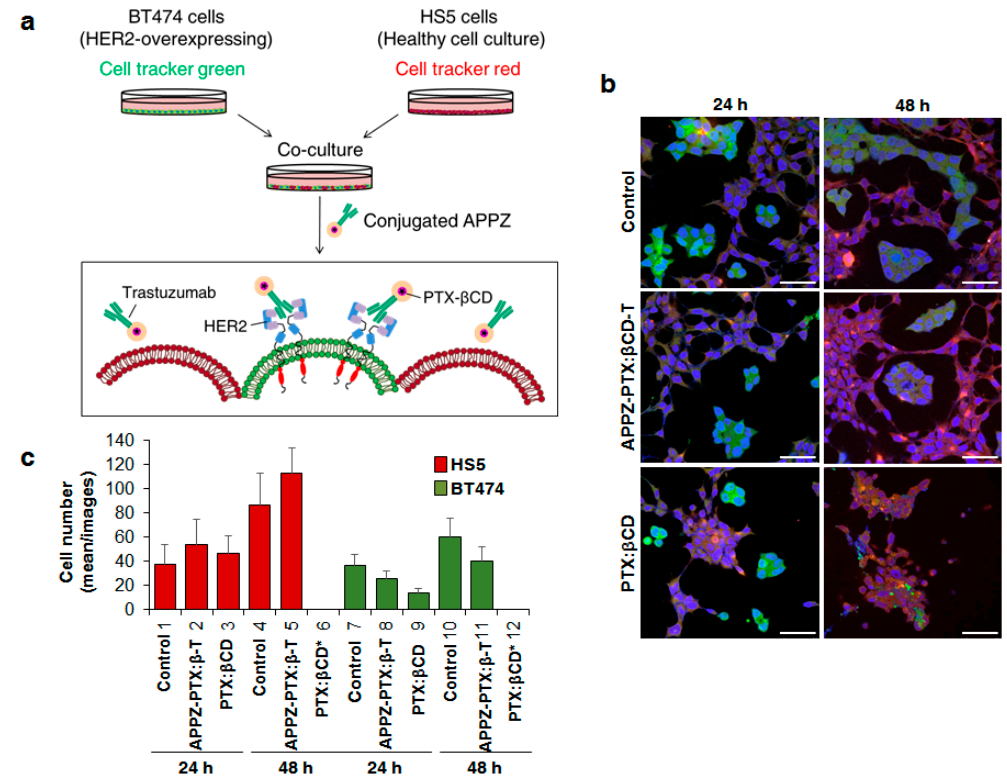
Figure 4. Targeting HER2-overexpressing cells with conjugated APPZ. ( a ) BT474 and HS5 cells were co-culture and treat equivalent free PTX: β CD complexes and conjugated APPZ. ( b ) Obtained results after the treatment of the co-cultured BT474 (green) and HS5 (red) cells, stained with DAPI (blue). Scale bar, 50 µ m. ( c ) Living BT474 and HS5 cells from 12 di ff erent confocal images were counted in order to analyze the specificity of the conjugated APPZ. Results are the mean of these 12 images ± SD. 3.5. Conjugated APPZ Have Di ff erent Cytotoxic E ff ect According to Cellular Levels of